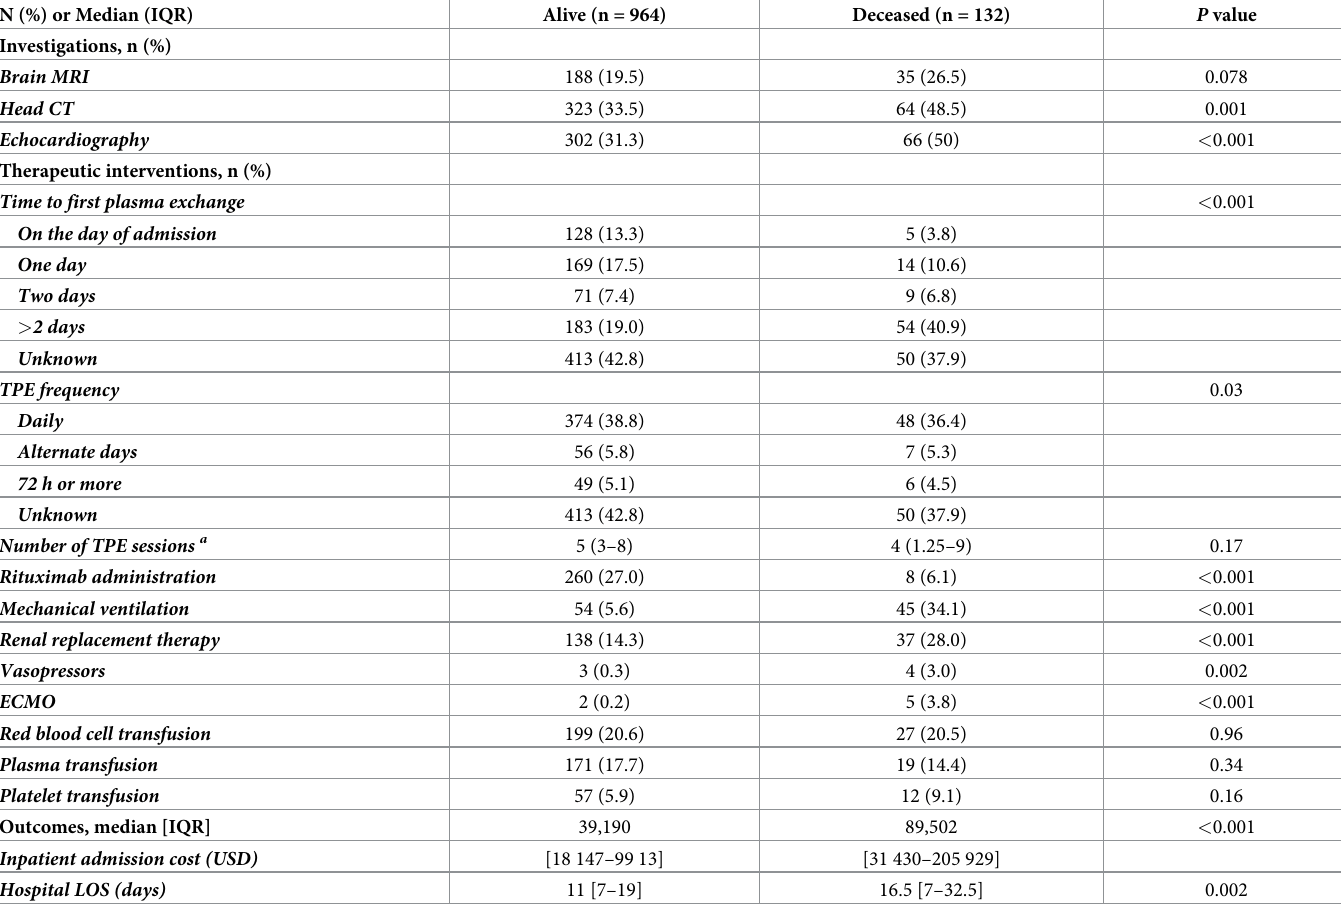
Table 2. Specific investigations, therapeutic interventions, and